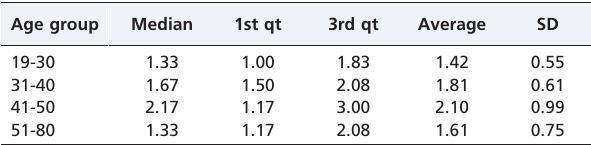
Table 5 – Distribution of the overall average values according to age